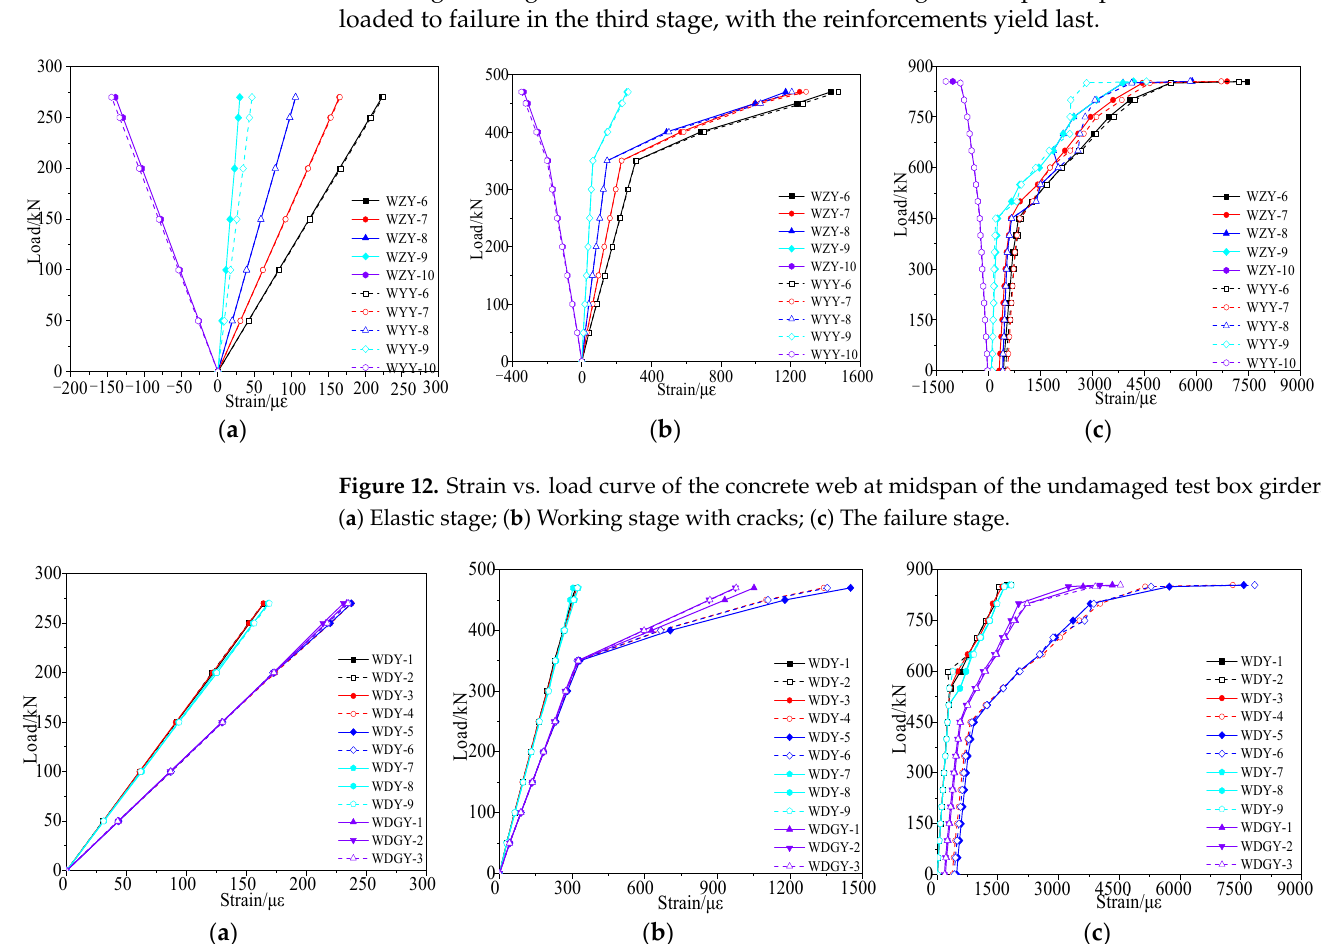
( c ) Figure 11. Deformation curve of the undamaged test box girder bottom plate. ( a ) First cycle of loading and unloading; ( b ) Second cycle of loading and unloading; ( c ) Third loading to failure.